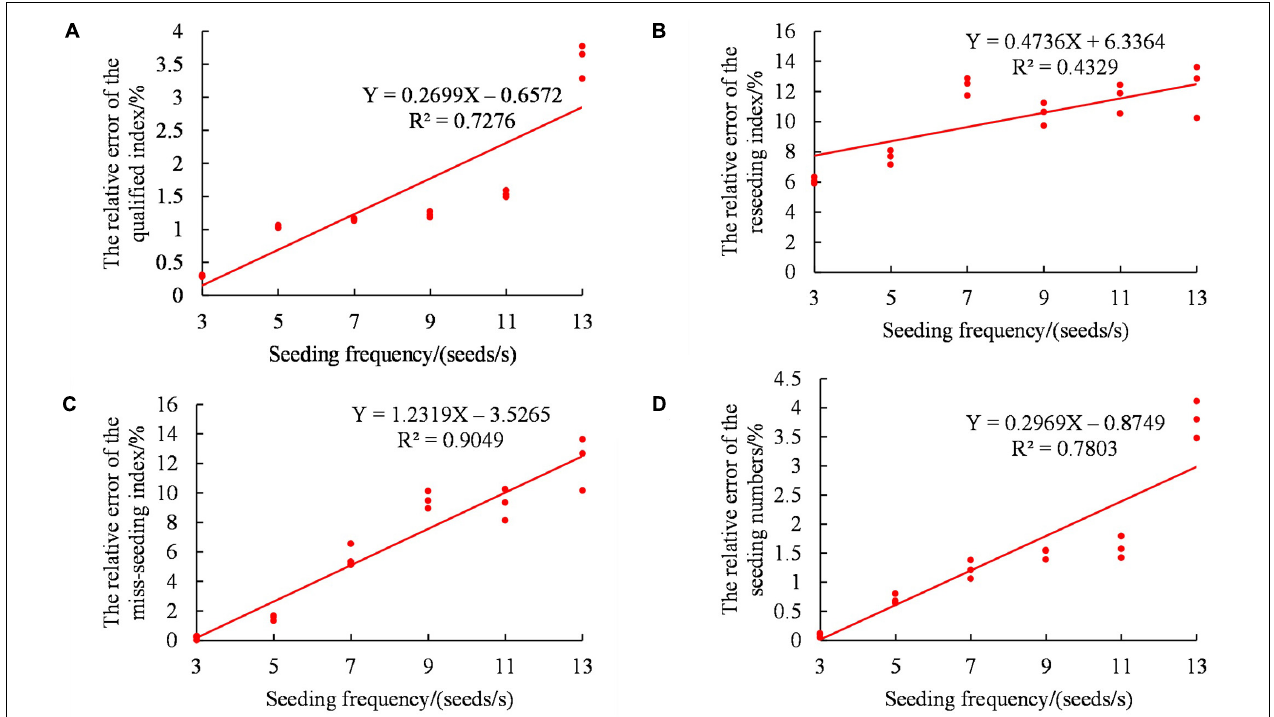
FIGURE 11 | Influence of the seeding frequency on the monitoring accuracy of the sensor. (A) Relative error of the qualified index. (B) Relative error of the reseeding index. (C) Relative error of the miss-seeding index. (D) Relative error of the seeding amount.